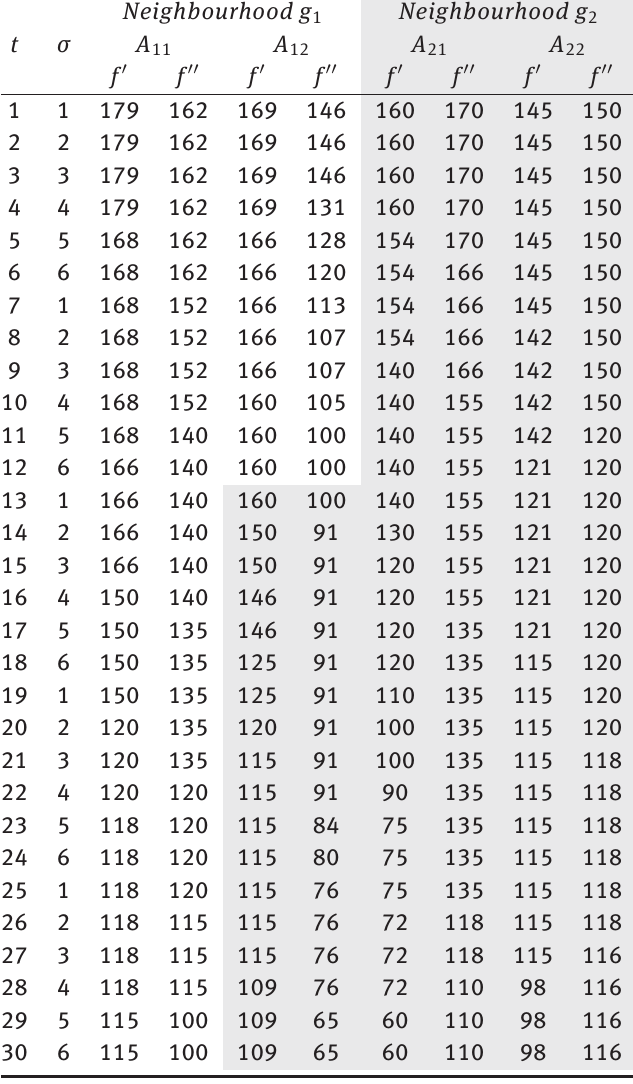
Table 1: Fitness values and Neighborhood switch by agent A